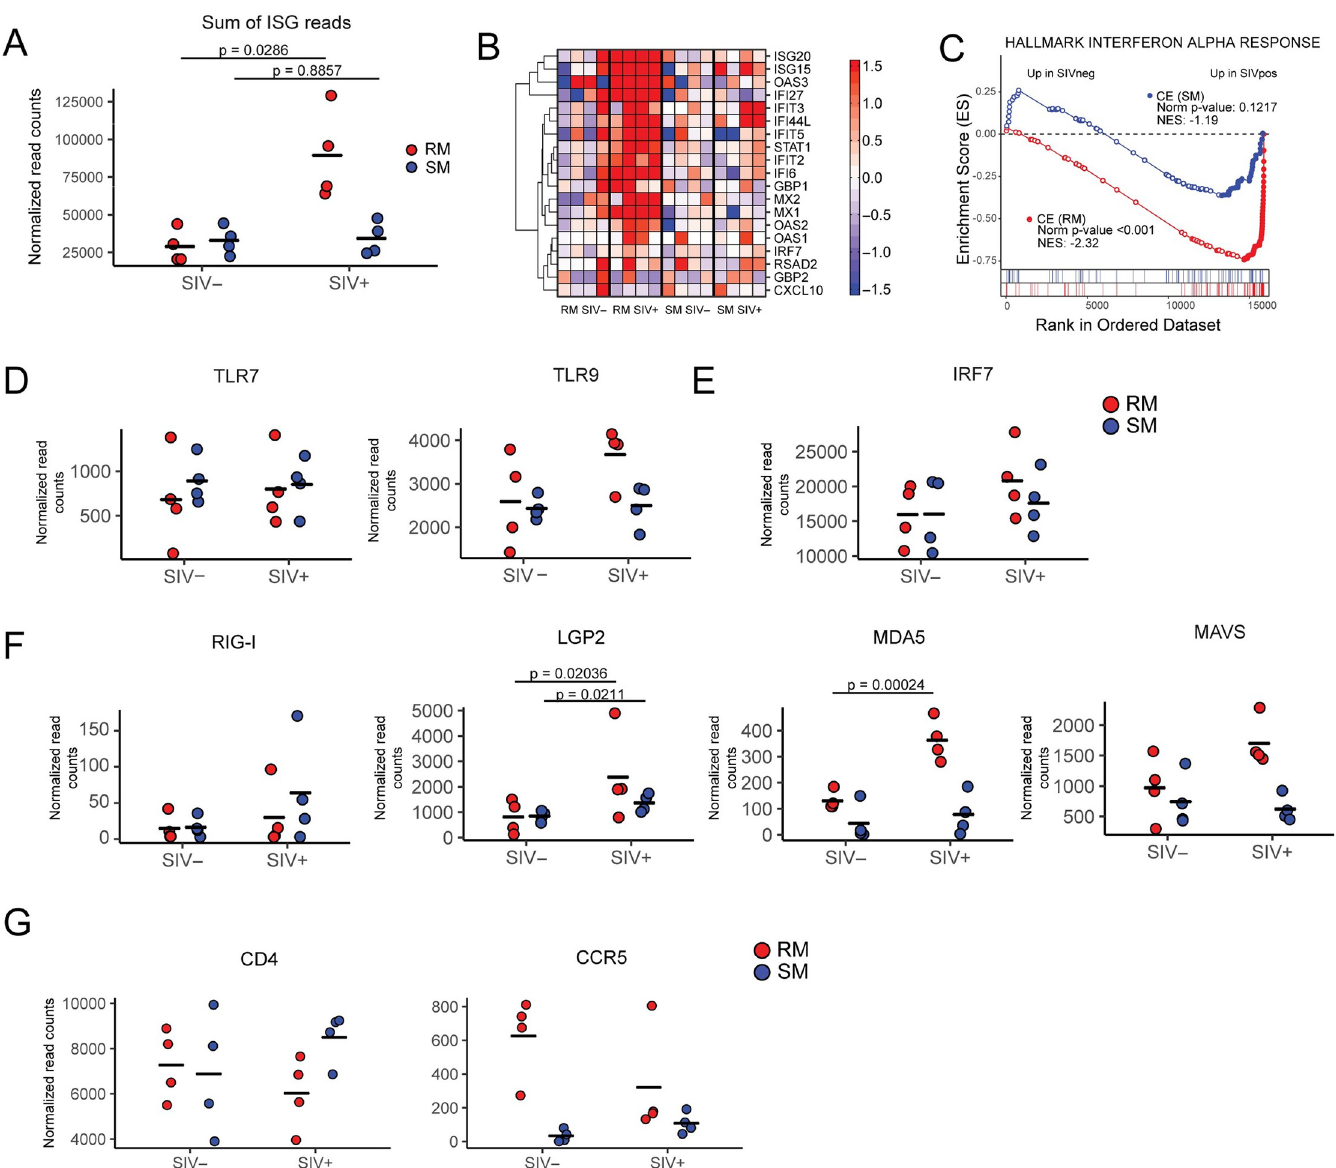
Fig 2. Persistent expression of interferon stimulated genes (ISGs) in peripheral blood pDCs in chronic SIV infection of RMs but not SMs. (A) Sum of all normalized read counts mapping to 19 ISGs known to be modulated in SIV infection of RMs [27]. (B ) Heat map of the 19 ISGs used in panel A. The values shown were first transformed using the “rlog” method from DESeq2, data were normalized by subtraction of the median (on a per-gene basis) of the baseline samples (i.e. SIV- RM and SIV-SM) from each datapoint; RMs data was normalized by the SIV-RM median and SM data by the SIV-SM median. The color scale of the heatmap is set to maximal at fold-changes of -1.5 and 1.5. (C) GSEA enrichment plot of the Hallmark interferon alpha response, (MSIGDB geneset #M5911) for contrasting expression in SIV- vs SIV+ for RMs and SMs, in two separate analyses depicted by the red and blue lines, respectively. This plot panel also shows NES and nominal p-values. Normalised read counts for the endosomal pattern recognition receptors, TLR7 and TLR9 ( D ), IFN signaling gene IRF7 ( E ) cytosolic pattern recognition receptors and associated signaling proteins, RIG-I, LGP2, MDA5 and MAVS ( F ) in uninfected and SIV-infected RM and SM peripheral blood pDCs. ( G ) Normalised read counts for the SIV receptor CD4 and co-receptor CCR5 contrasting SIV- and SIV+ RMs and SMs. All plots show values for individual RMs and SMs and black line indicates mean, n = 4 for each condition. “Normalized” refers to size factor normalization from DESeq2. In ( A) , statistical significance was determined using a Mann Whitney test, comparing infected and non-infected samples from the same species. In ( D )–( G ), only significant p-values from DESeq2 analysis is